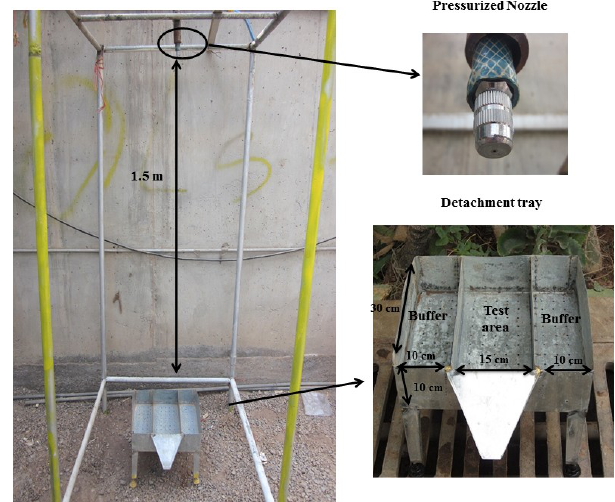
Figure 2. The rainfall simulator and detachment tray used in the